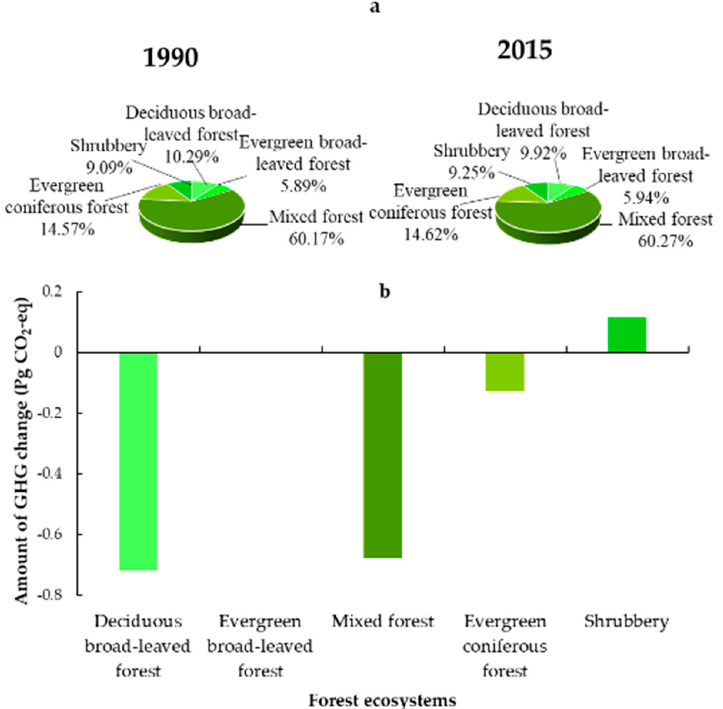
Figure 5. Greenhouse gas (GHG) change in different forest ecosystems: ( a ) Proportion of GHG in various forest ecosystems in 1990 and 2015; ( b ) Amount of GHG change in various forest ecosystems in China during 1990–2015.